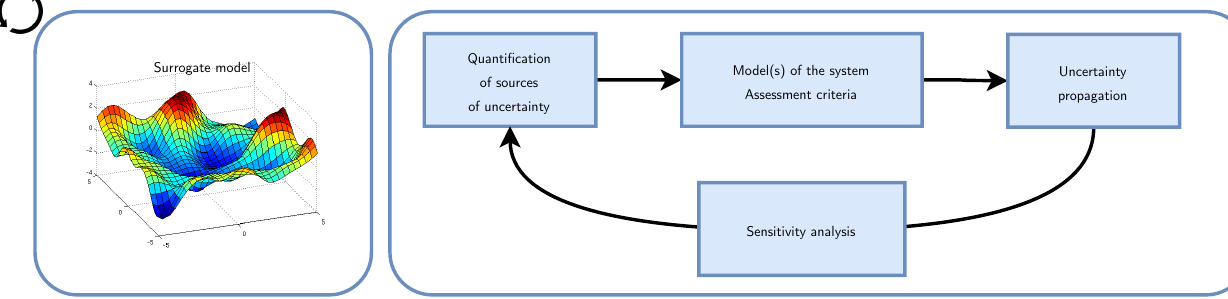
Figure 11. Global framework for uncertainty quantification [91]. This framework is used to model the distribution Q controlling the various scenarios that the activity recognition model will likely encounter in real-life deployment settings.